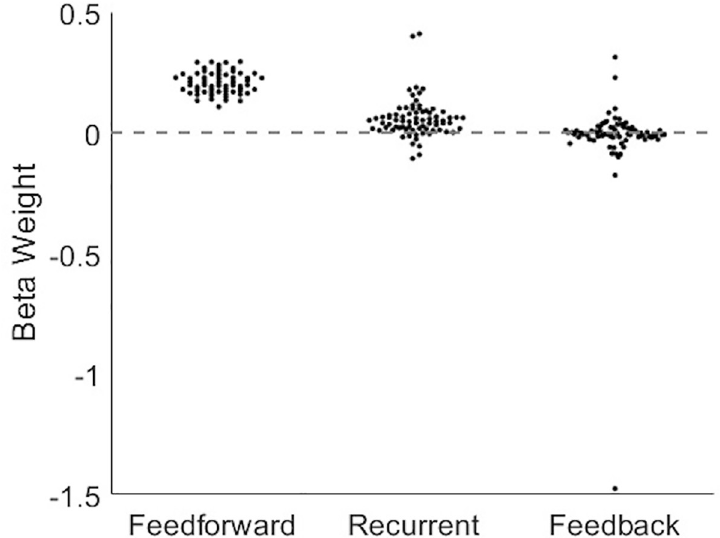
Fig 8. The strength of feedforward and recurrent edges was predictive of normalized synergy. Histograms of beta weights for multiple linear regressions performed on the network-level revealed that feedforward and recurrent edge weights were reliable predictors of normalized synergy, across networks. Feedback edge weight was not a reliable predictor of normalized synergy.